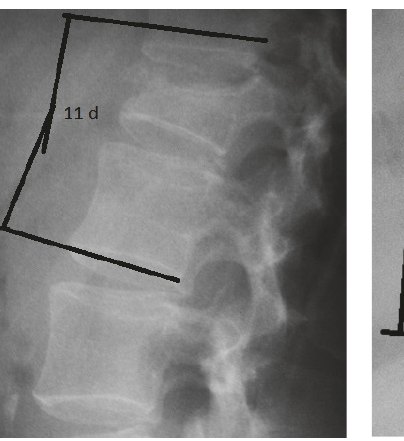
averaged 1.5 ml (range: 1-2 ml) and did not differ from PMMA with average volumes of 2 ml (range: 1–2.5 ml) (Group B) ( 𝑃 = 0.64